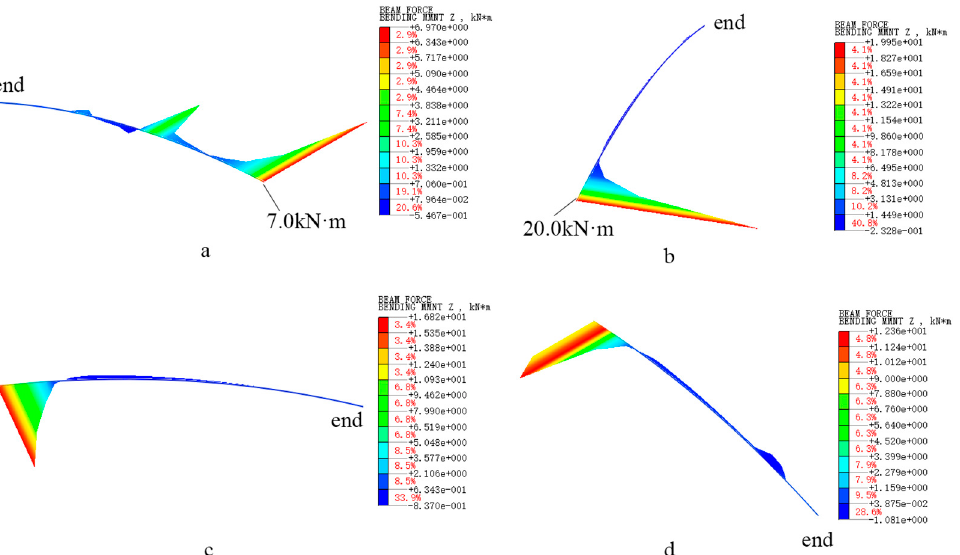
Figure 12. Bending moment diagrams of the first layer lateral roots: ( a ) No. 1 lateral root, ( b ) No. 2 lateral root, ( c ) No. 3 lateral root, ( d ) No. 4 lateral root.